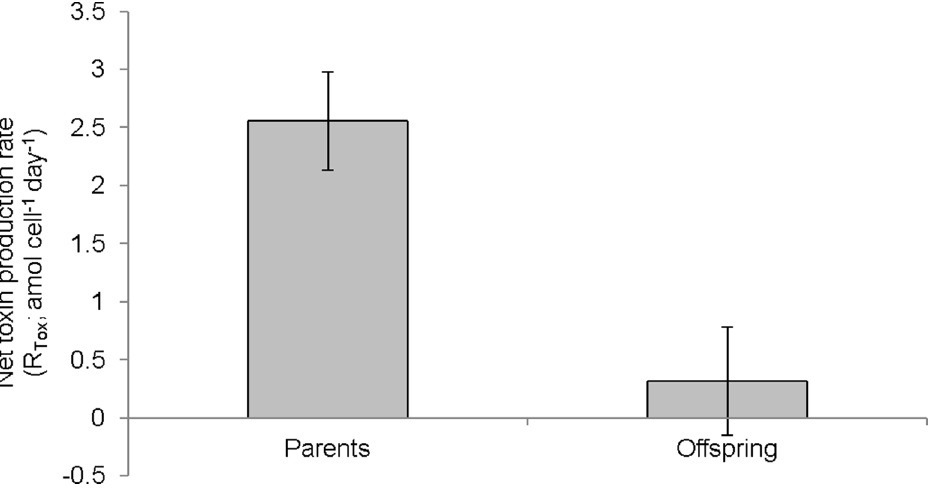
Figure 3. Comparison of the net toxin production rate (R tox ) of parents (2 strains) and offspring (25 strains). Error bars= 6 SE, n=10 in parents and 25 in